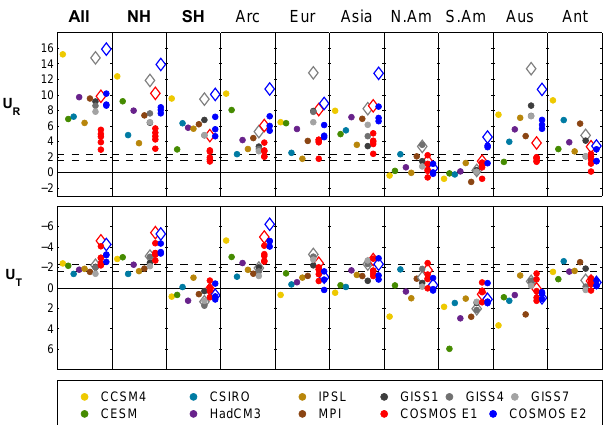
Figure 9. Correlation ( U R ) and distance ( U T ) statistics for PAGES 2k regions, with hemispheric and global combinations of all re- gional data, in the period 861–1850 CE. Positive U R indicates that simulations and reconstructions have a positive correlation and that they share an effect of temporal changes in external forcings. Neg- ative U T indicates that a forced simulation is closer to the observed temperature variations than its own control simulation. The analy- sis reveals a notably better general agreement between simulations and reconstructions for the Northern Hemisphere as compared to the Southern Hemisphere. Coloured dots: individual simulations. Diamonds: ensemble-mean results for COSMOS and GISS models. Dashed lines show one-sided 5 and 1% significance levels. Note the reversed vertical axis in the U T